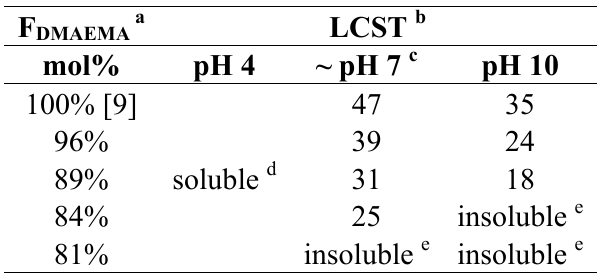
Table 5. Lower critical solution temperature (LCST) of poly(DMAEMA- stat -styrene) at different pH at 0.5 wt%